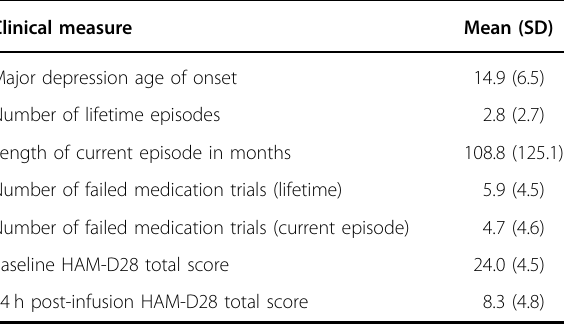
Table 1 Study sample clinical